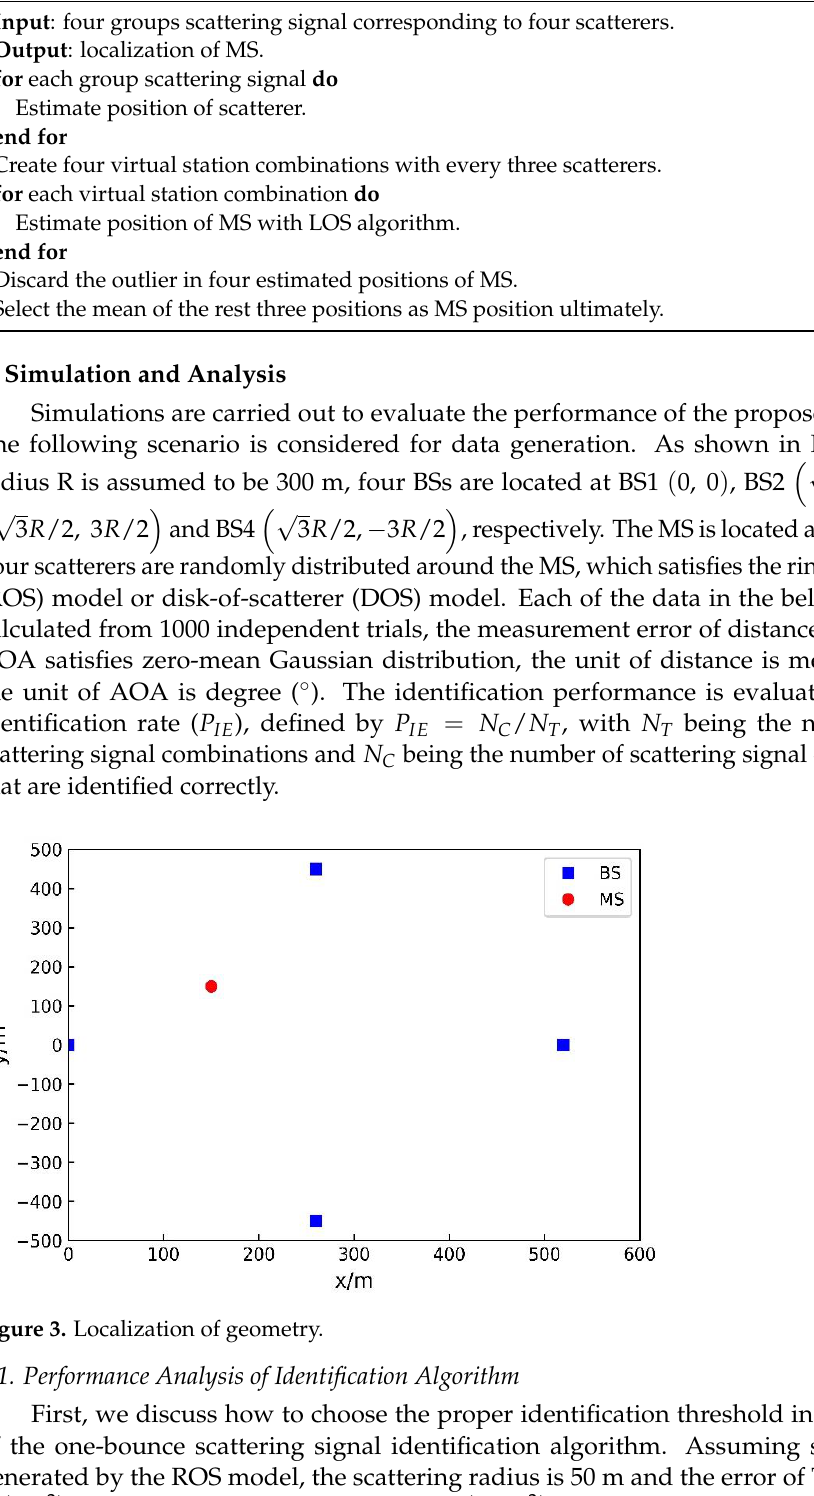
Figure 4. Effect of identification threshold on false alarm probability and alarm dismissal probabil- ity. The 𝑃 𝐼𝐸 versus scattering radius comparison is presented in Figure 5. The scattering radius is 10 m, 20 m, 30 m, 40 m, 50 m, 60 m and 70 m, respectively. The scatterers are generated following the ROS model or DOS model. The error of TOA satisfies 𝑁(0, 1 2 ) , and that of AOA satisfies 𝑁(0,0. 5 2 ) . It can be observed that with the increasing scattering